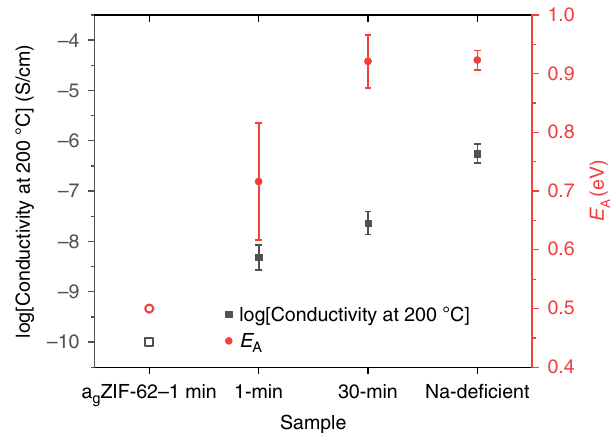
Fig. 9 Ionic conductivity measurements. Measurements of ionic conductivity at 200 °C of the (a g ZIF-62) 0.5 (Na-de fi cient) 0.5 – 1 min, (a g ZIF- 62) 0.5 (Na-de fi cient) 0.5 − 30 min and Na-de fi cient samples along with the activation energy extracted from the gradient of the conductivity- temperature measurements (see methods). Data for a g ZIF-62 – 1 min are predictions only (see text) and are represented with open